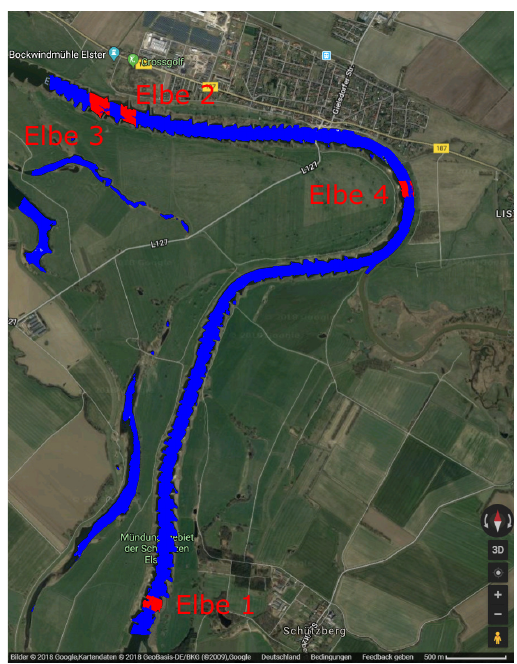
Figure 3. The study area (part of the river Elbe) including subregions for development and evaluation of the extended approach. (Map data c (cid:13) 2018 Google)